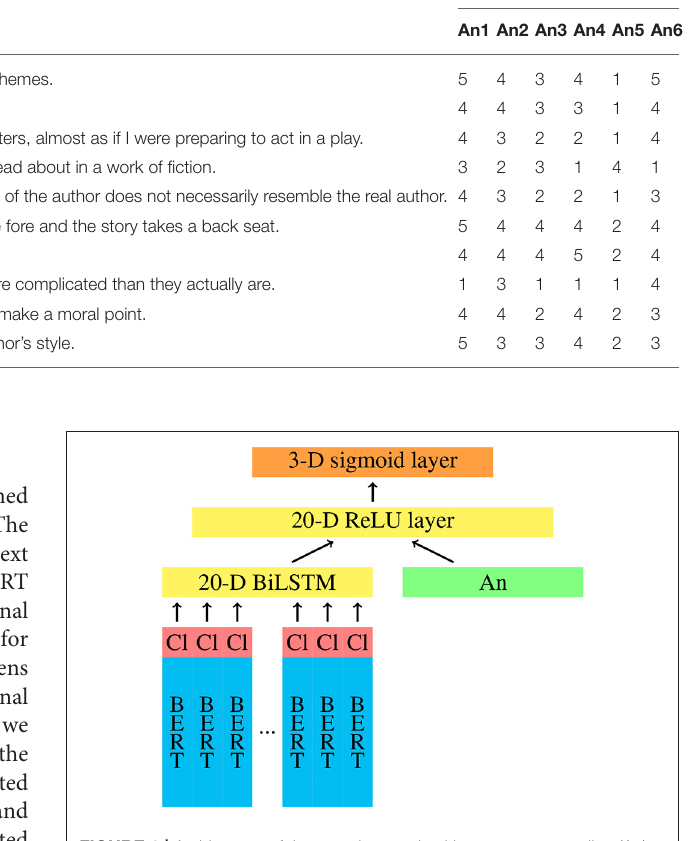
TABLE 7 | Overall top-10 questions with the answers given by the annotators. Rank Question Text (English version)